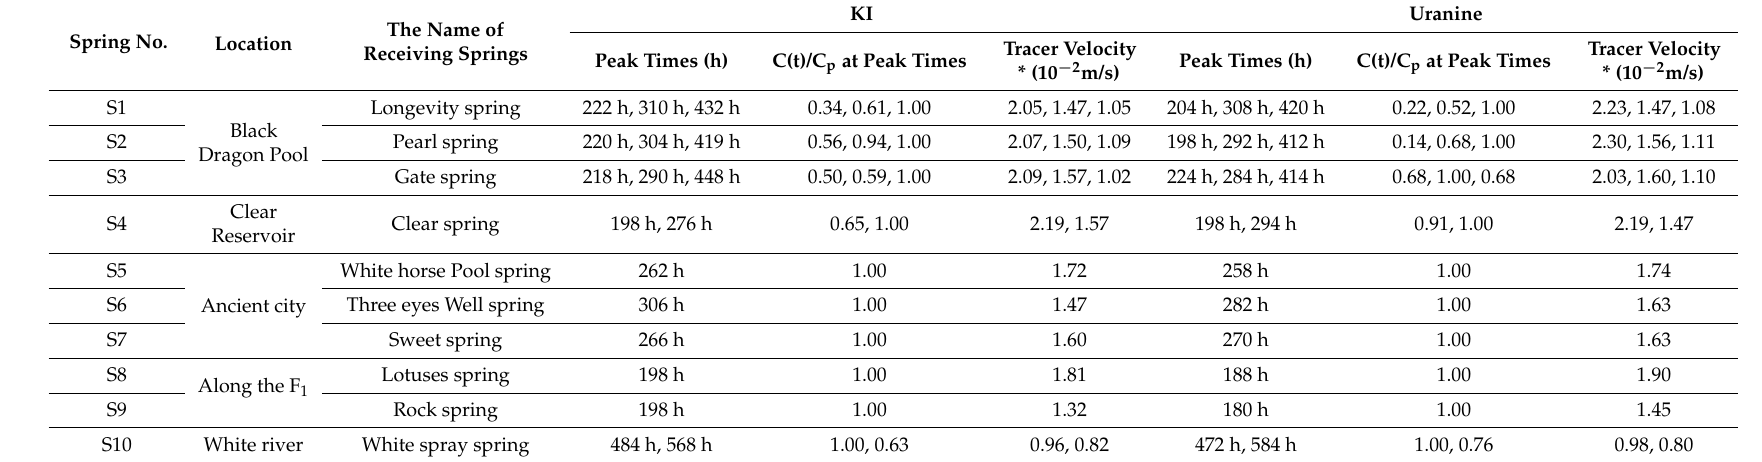
Table 4. Peak times and C(t)/Cp at peak times for every receiving point.